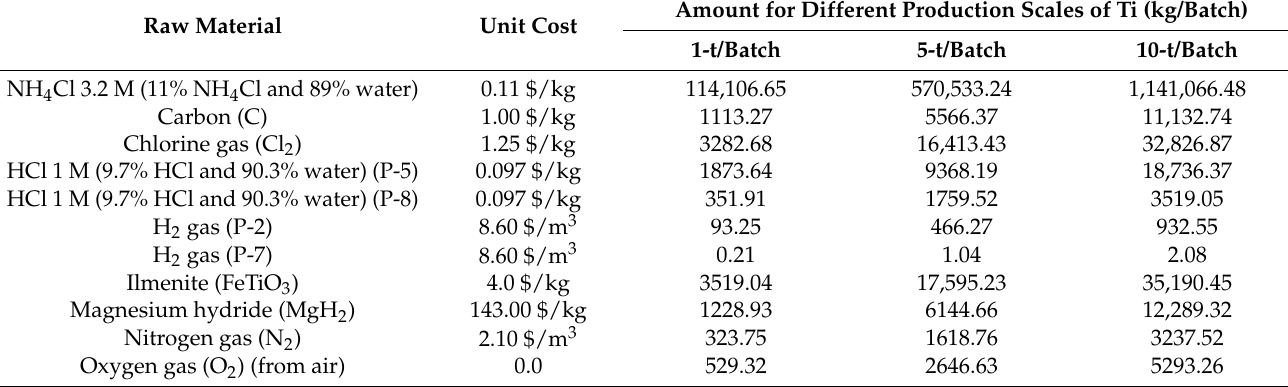
Table 3. The required amount of raw material with their unit costs for different production scale.